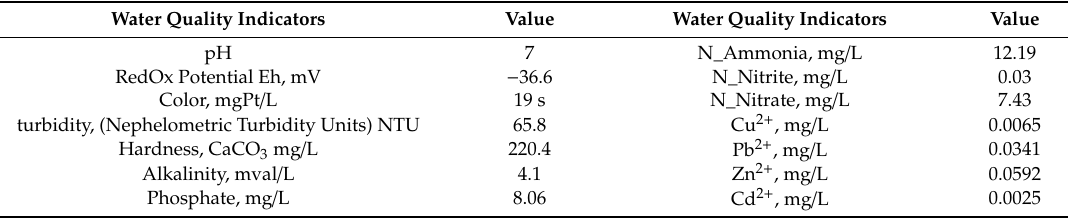
Table 4. General characteristics of the tested e ffl uent from a